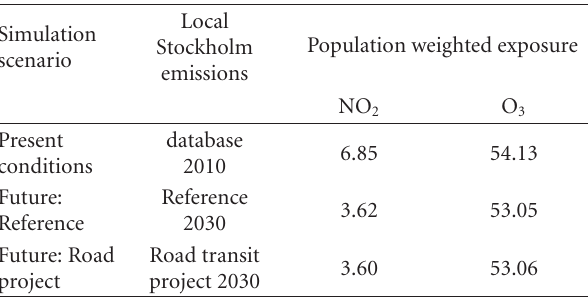
Table 3: Population-weighted average exposure given for a total population of 1 463 780 persons living inside the modeling domain. Model simulations performed for the smaller Stockholm domain with 1 × 1km 2 spatial resolution. Air quality simulations were made for the single year 2010 and 2030, with RCA3 downscaled ECHAM5 A1B-r3 meteorology and time varying RCP4.5 emissions over Europe. Unit: µ gm − 3